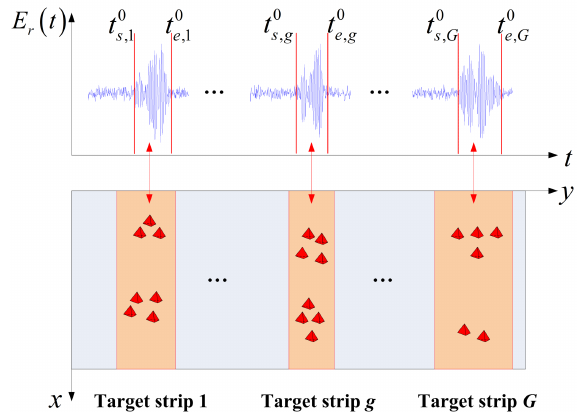
Figure 2. Received signal of the clustered targets in a narrow pulse MSCI. G is the number of target